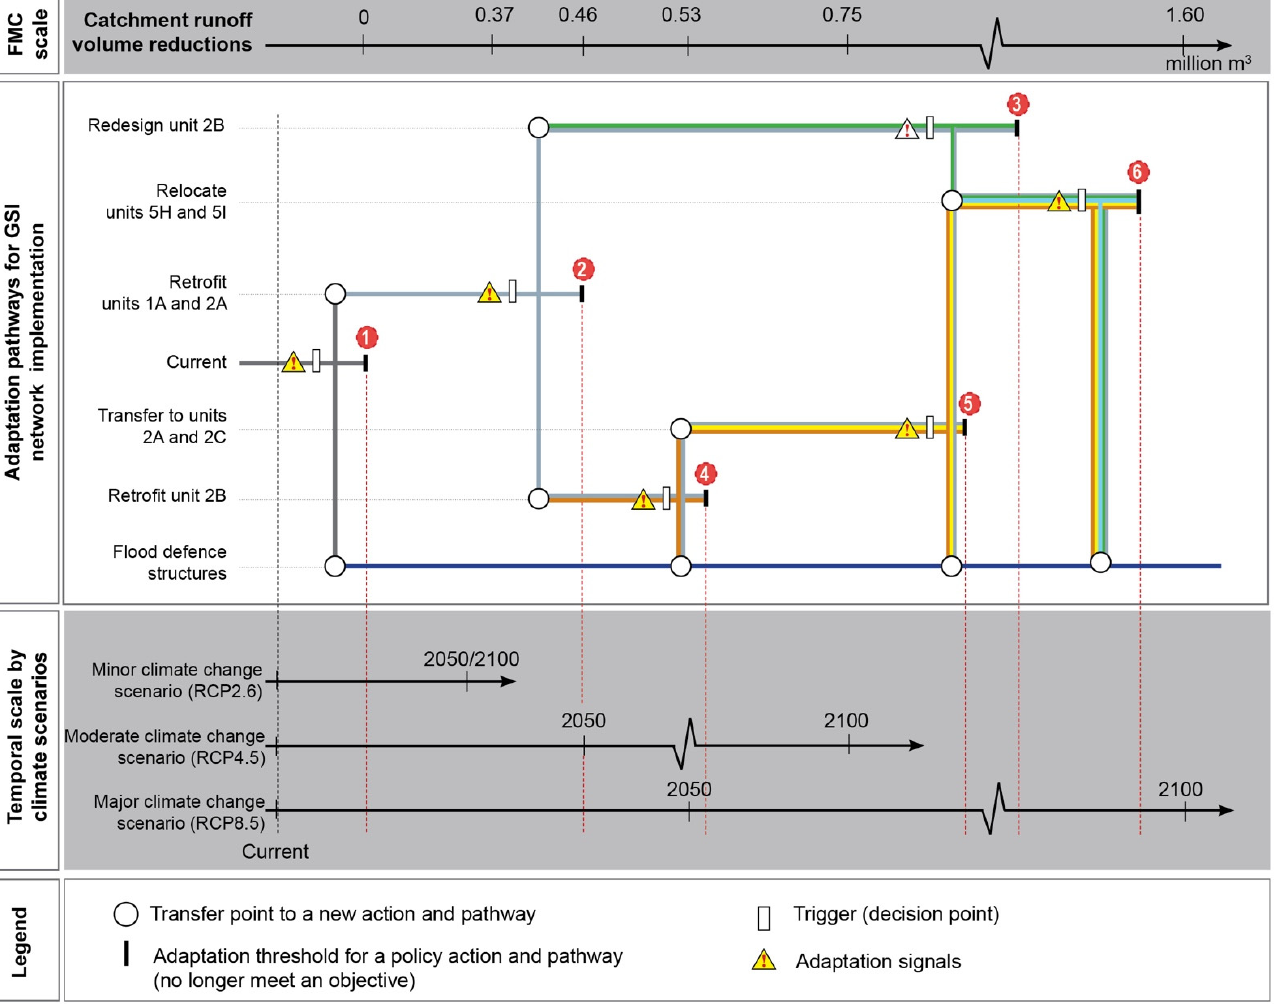
Figure 12. The proposed adaptation pathways for implementing an industrial GSI network in the Heathcote River catchment over this century to supplement the primary catchment flood mitigation system. The projected lines (cid:202) to (cid:207) indicate the adaptation threshold of each